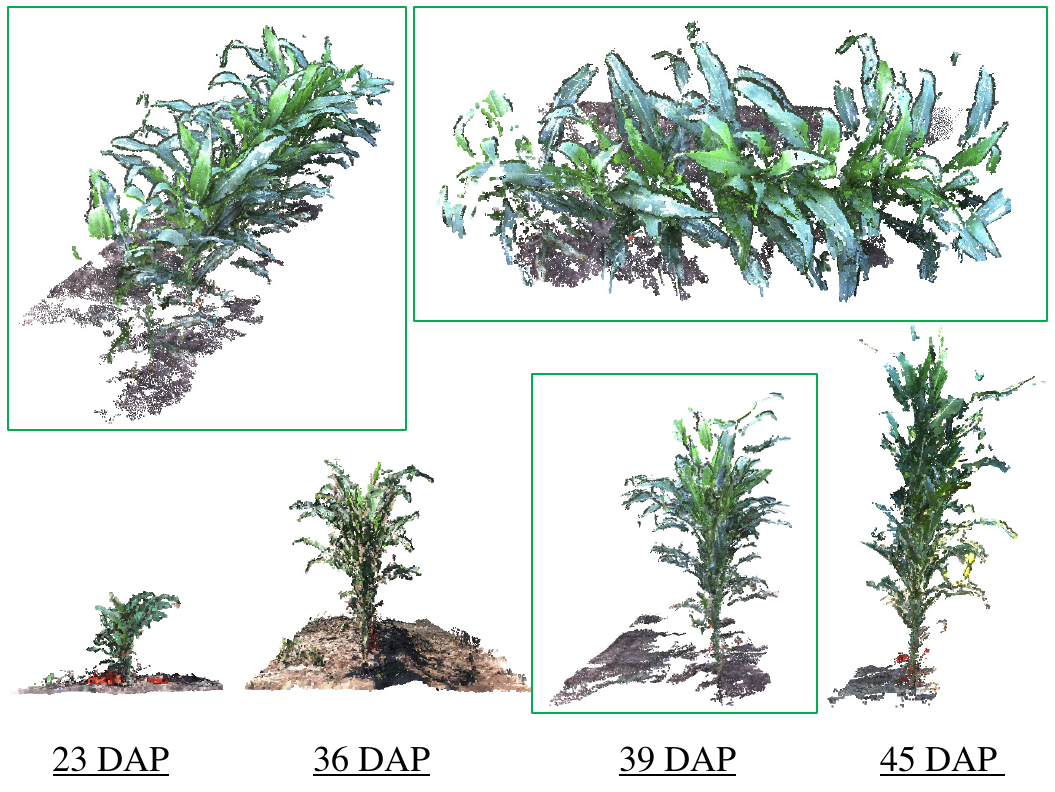
Figure 6. Typical examples of 3D reconstructed plants at four different DAP (days after planting) using stereo images collected by the Vinobot in rows 17 and 18 in Figure